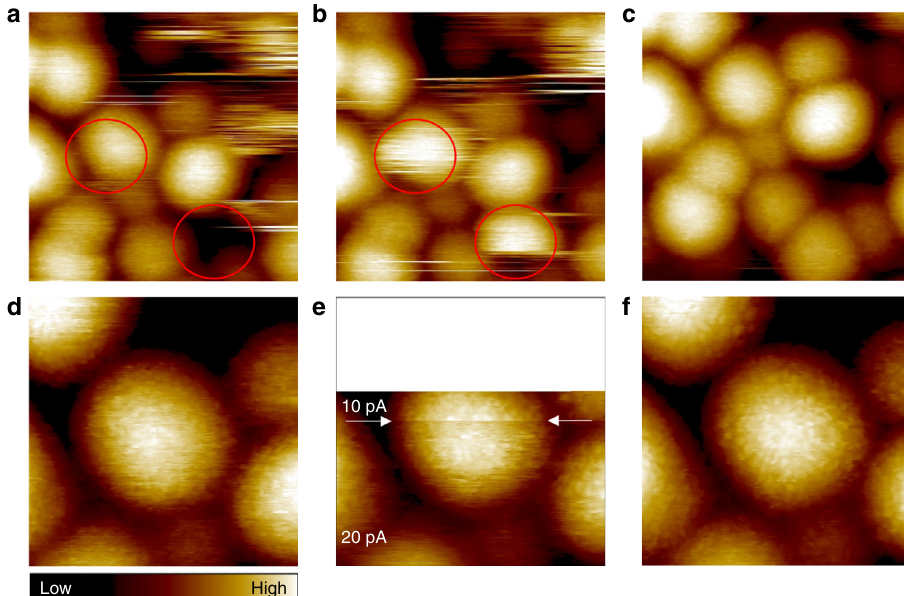
Fig. 2 Repeated imaging of the same sample area increases the resolution. Bias, setpoint current, scan size: a , b − 1.2 V, 30 pA, 23.7 × 23.7 nm 2 c − 1.2 V, 20 pA, 23.7 × 23.7 nm 2 d − 1.2 V, 20 pA, 12.0 × 12.0 nm 2 e − 1.2 V, setpoint current change from 20 to 10 pA at the marked scan line, 12.0 × 7.8 nm 2 ; and f − 1.2 V, 10 pA, 12.0 × 12.0 nm 2 . Red circles indicate unstable clusters and some were removed by tip in in a , b . Repeated imaging of the same area with decreasing setpoint current improved the spatial resolution markedly. Images taken at the LHe temperature over the course of 7 min/image